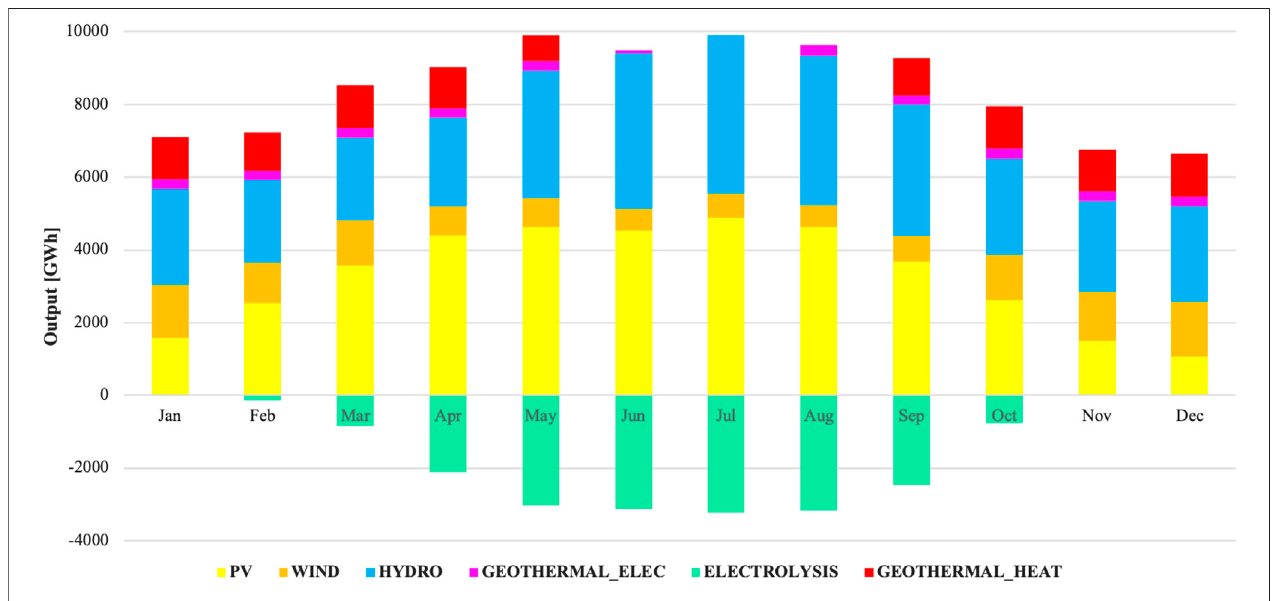
FIGURE 10 | Monthly production of renewables.